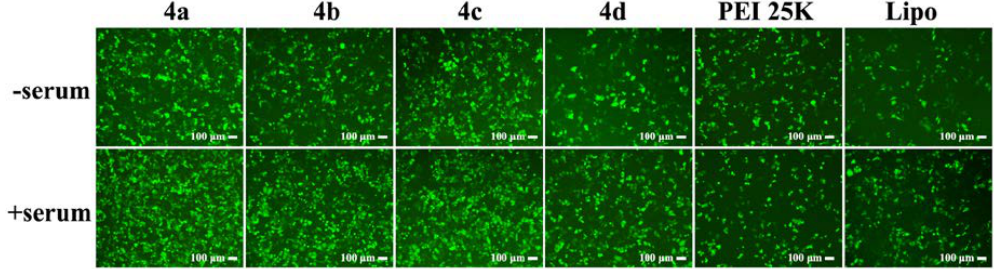
Figure 4. Fluorescence microscope image of pEGFP-transfected HeLa cells at optimal weight ratios in the absence of serum (2 for 4a – d ) or in the presence of 10% FBS (4 for 4a and 4d , 2 for 4b and 4c ).